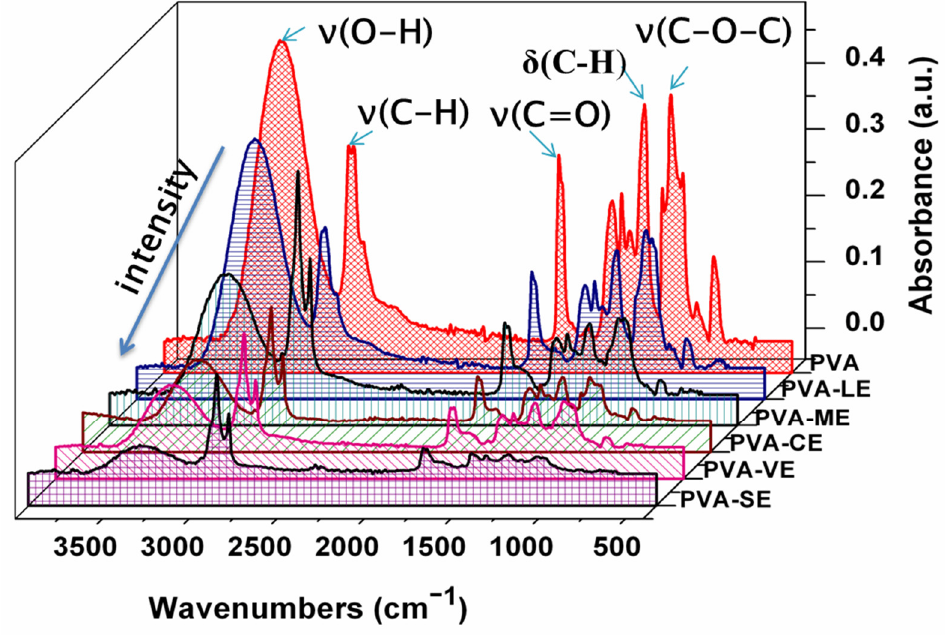
Figure 3. ATR-FTIR spectra of PVA and PVA films loaded with plant extracts. The analysis shows that the characteristic peaks of poly(vinyl alcohol) and plant extracts have almost similar functional groups, but the intensities of the peaks are different. Thus, the large band between 3500 and 3200 cm − 1 was attributed to the stretching vibrations ν (O-H) and intermolecular hydrogen bonding vibration [52,53]. Two bands with maxima at 2938 cm − 1 and 2858 cm − 1 are the asymmetric and symmetric stretching vibrations − 1 , it was found the characteristic band of the ν (C-H) of -CH 2 groups. At 1733 cm